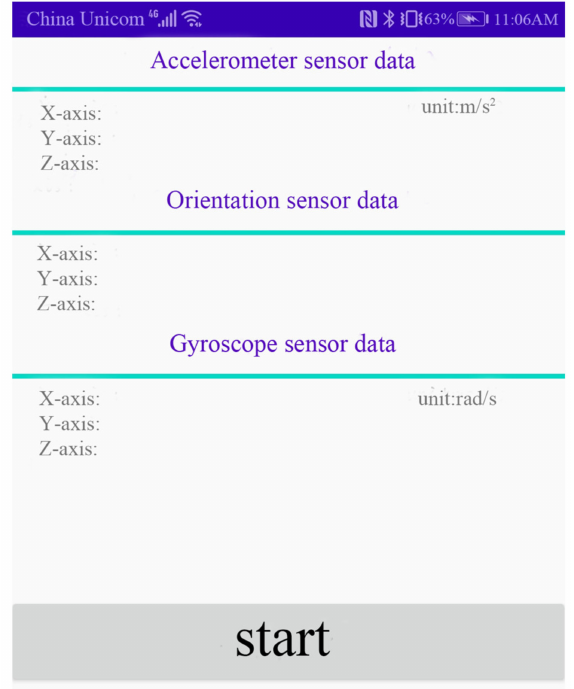
Figure 2. Software interface for data